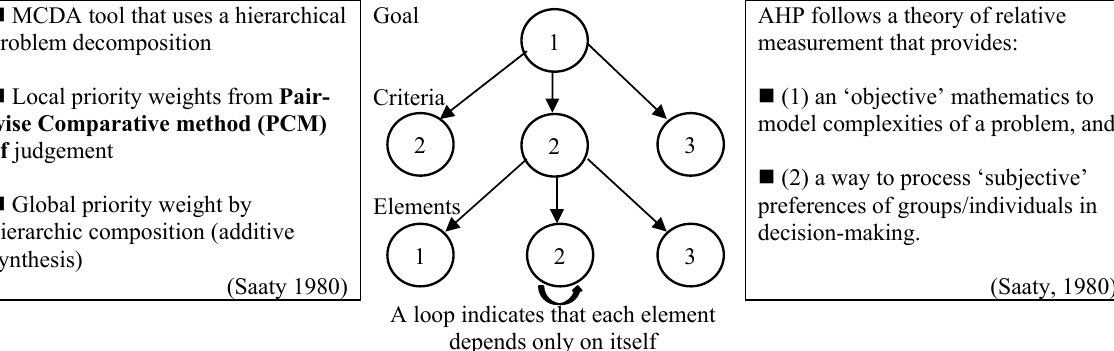
Fig. 1. Analytical Hierarchy Process (AHP) Model (Saaty T. L., 1990)